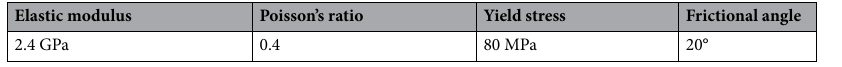
Table 2. Material parameters for material model in FEM